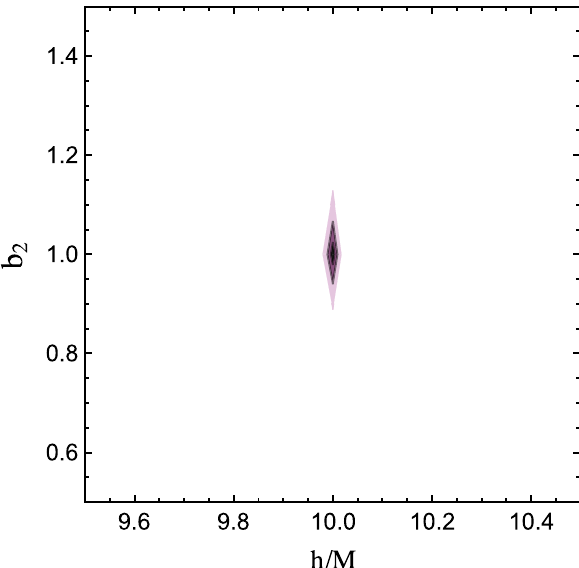
Fig. 5 b 2 vs h contour levels from analysis of the 2D transfer function. The reference model is a Kerr BH with a (cid:6) ∗ = 0 . 9 , h (cid:6) = 10 and i (cid:6) = 55 ◦ . See the text for more details